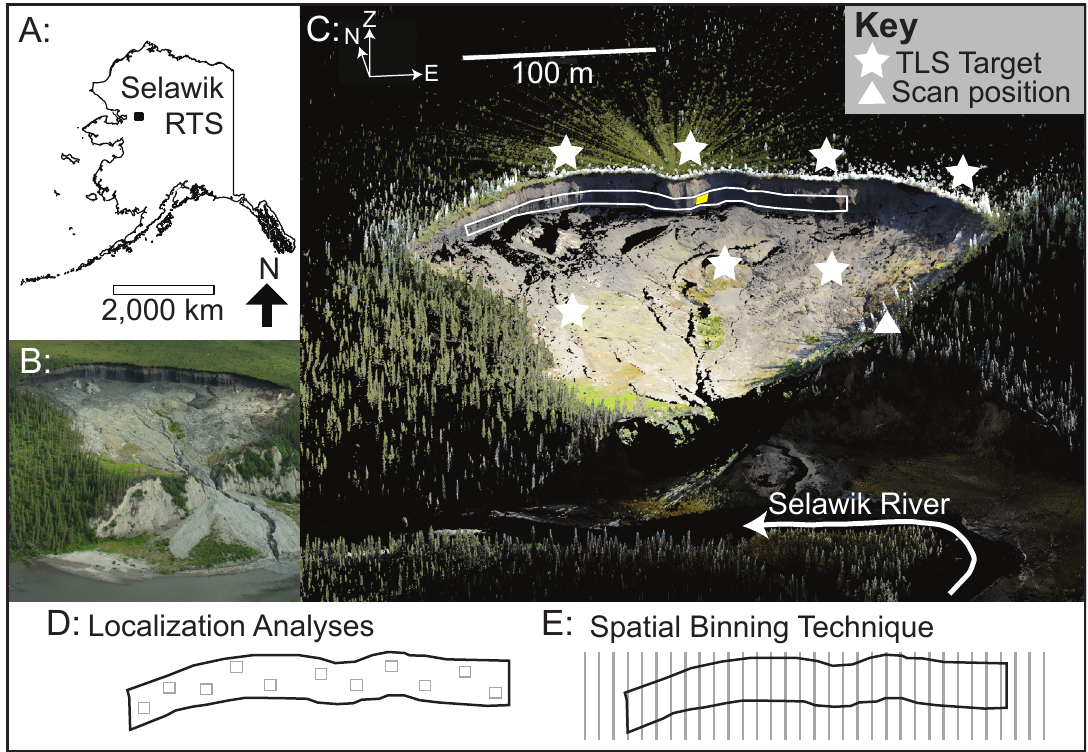
Key TLS Target Scan